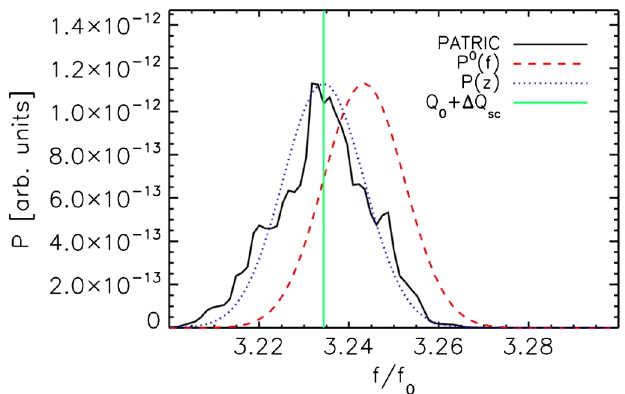
FIG. 7. (Color) Schottky spectrum from the PATRIC simulation with a constant imaginary impedance and space charge. The impedance and space charge parameters are U The dashed red curve represents the noise spectrum for U (cid:4) 0 . The vertical green line represents the shifted tune U coh (cid:8) (cid:2) Q . Q coh ; inc (cid:4) Q 0